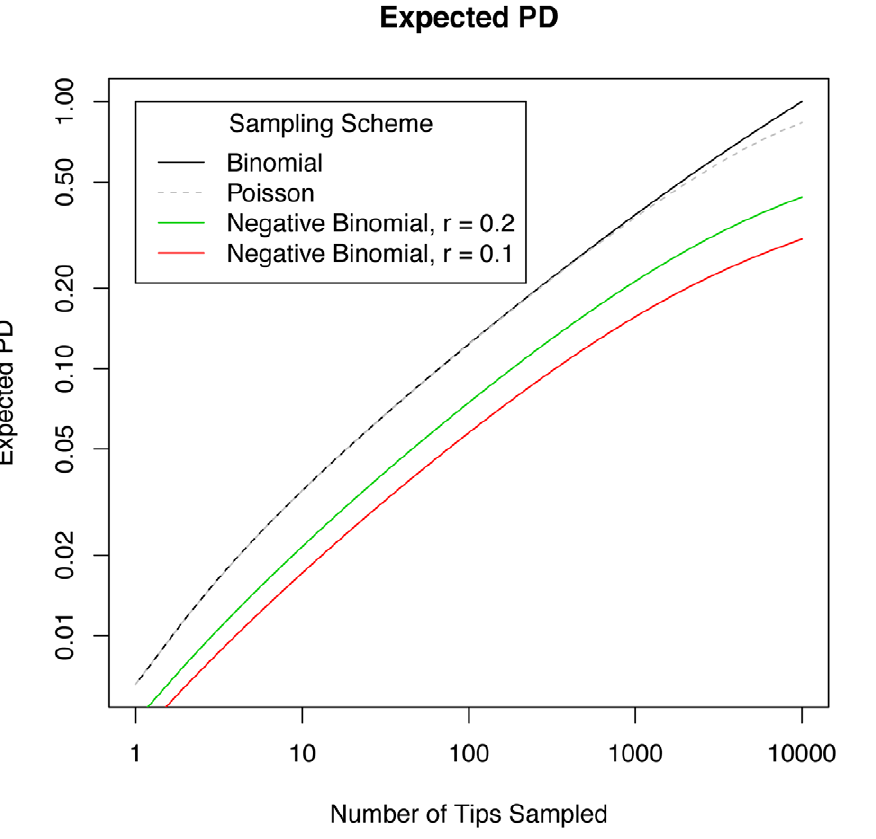
Figure 4. Expected PD for a sample taken from a theoretical metacommunity with a power-law Edge-length Abundance Distribution, S ( k ) ! k { a for various sampling schemes. As an approximation to the real communities in Figure 3, we take a ~ 1 : 5 . The resulting expected PD for Binomial sampling is close to a power law as a function of number of tips sampled, with E ( PD ) ! n a { 1 . We show the corresponding result for Poisson sampling, representing sampling with replacement which is identical to the binomial result until sample size becomes large. Finally, we show two negative binomial schemes with different clustering parameters, r ~ 0 : 1 , 0 : 2 (see Supplementary Information). These parameters are consistent with different degrees of phylogenetic clustering, which leads in general to smaller sampled PD for a given number of tips.